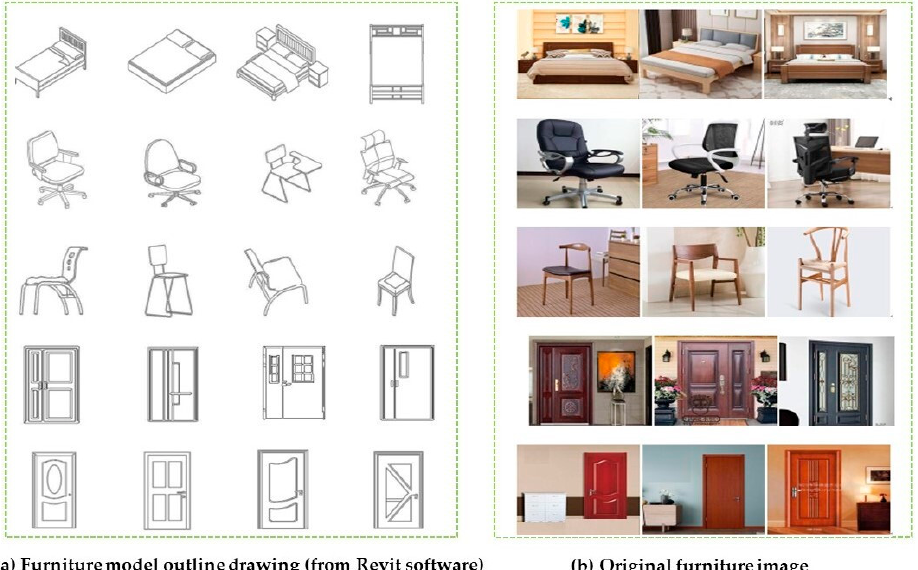
Figure 5. Some examples of the furniture dataset collected by us.